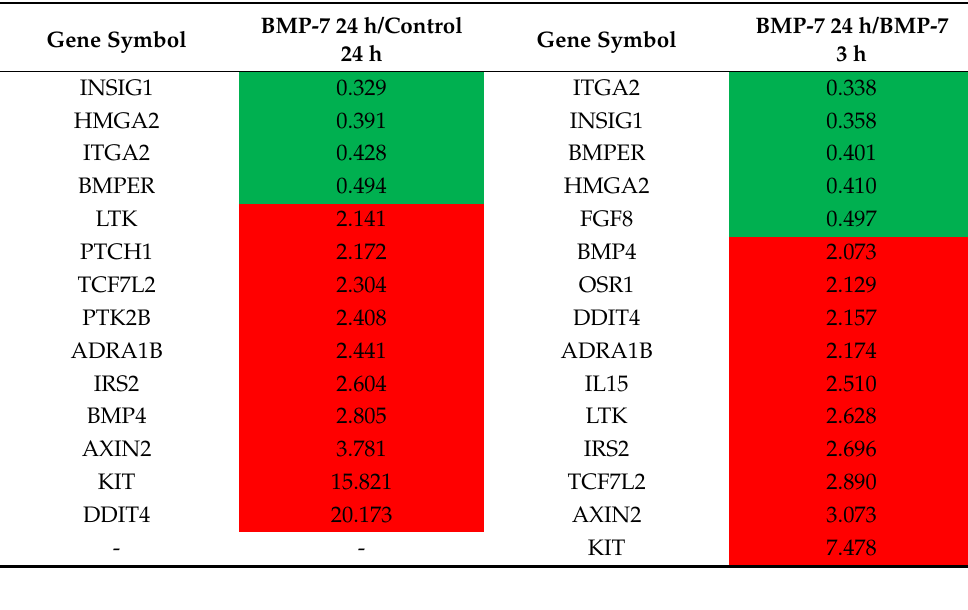
( B ) Figure 4. Clustering analysis of differentially expressed mRNA related to cell proliferation ( A ) BMP-7 at 24 h/control at 24 h and ( B ) BMP-7 at 24 h/BMP-7 at 3 h (fold change fold change of greater than 2, log2 normalized read counts >4 were selected). Differentially expressed mRNA related to cell differentiation is shown in Table 2 (fold change of greater than 2, log2 normalized read counts >5 were selected). Comparison of the BMP-7 at 24 h versus control at 24 h revealed that 41 mRNAs were upregulated and 48 were downregulated. Comparison of the BMP-7 at 24 h versus BMP-7 at 3 h revealed that 38 mRNAs were upregulated and 50 were downregulated. Clustering analysis of dif- ferentially expressed mRNA related to cell differentiation is shown in Figure 5.